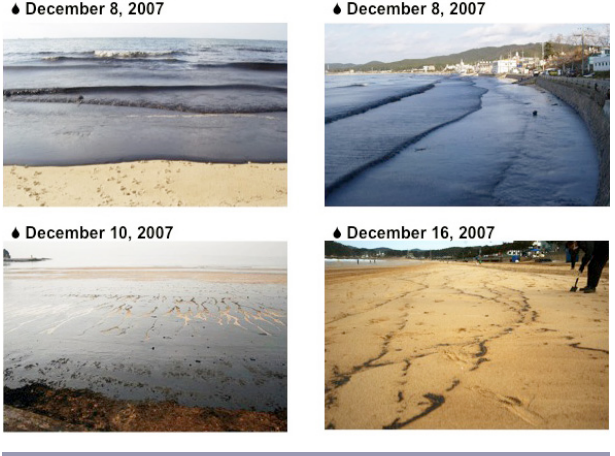
Fig. 1 . Hebei-Spirit oil spill cleanup over one week at Mallipo, South